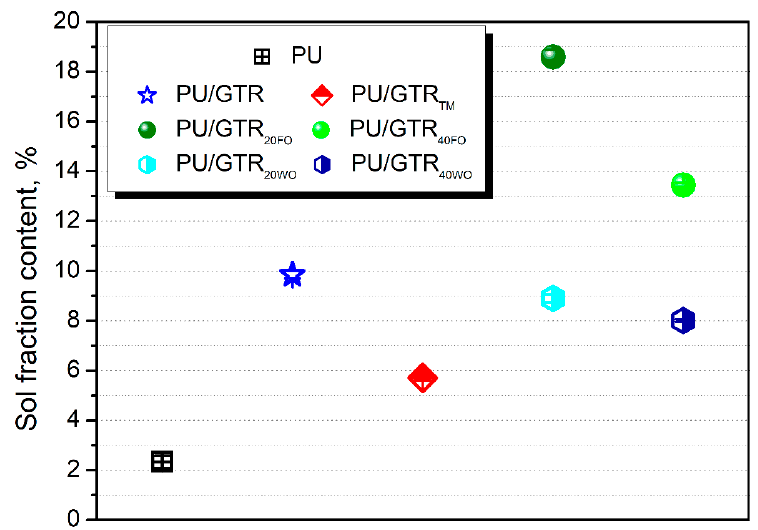
Figure 7. Sol fraction content for prepared polyurethane foams.